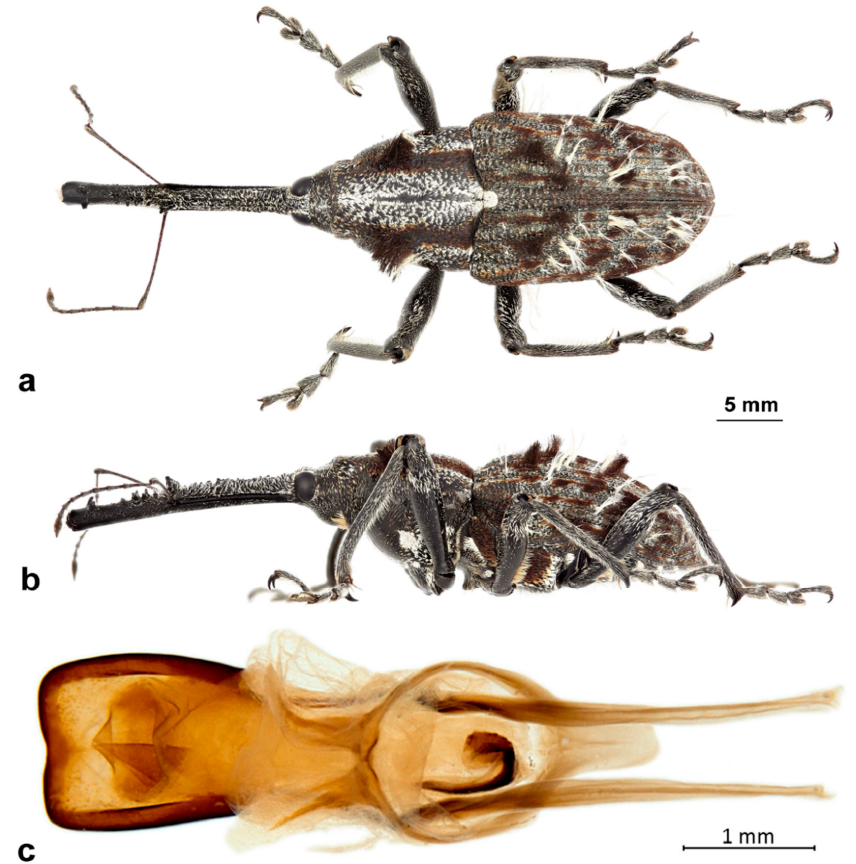
Figure 3. Eurhamphus fasciculatus : ( a ) habitus of male, dorsal aspect; ( b ) habitus of male, lateral aspect; ( c ) aedeagus, dorsal aspect.